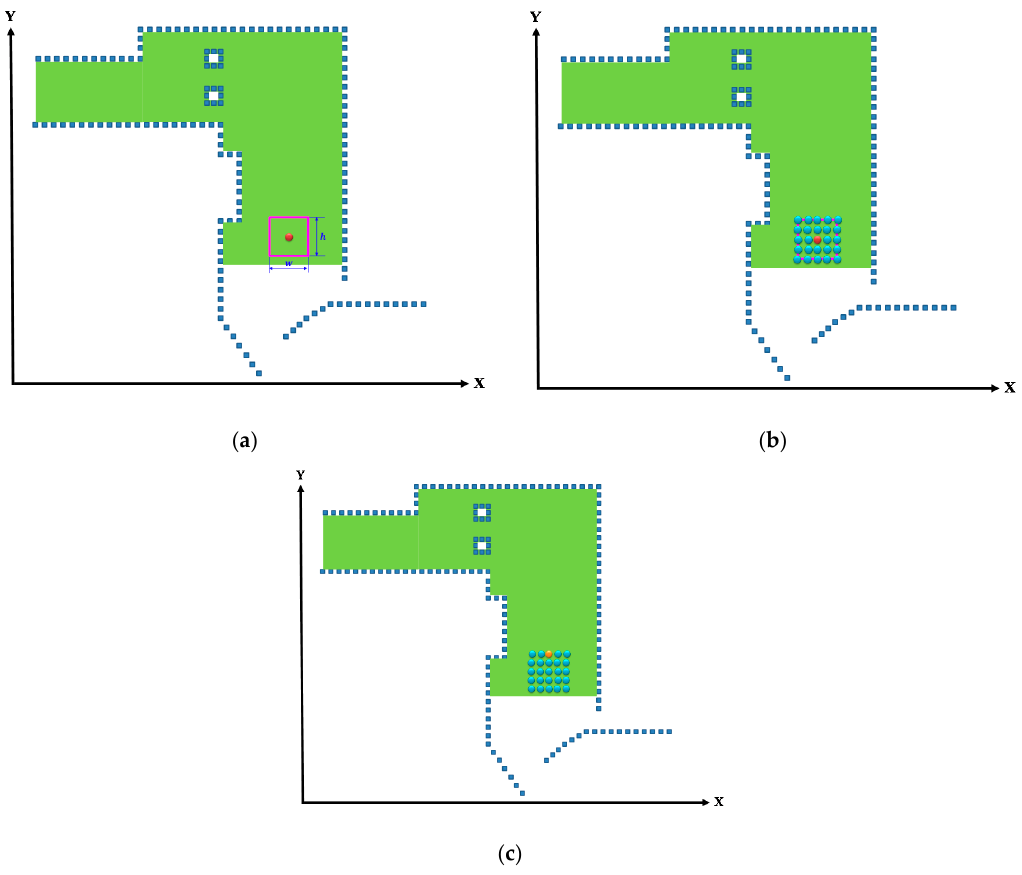
Figure 8. Locating the vehicle through window-based localization. ( a ) Window search area. ( b ) Current possible locations of the vehicle. ( c ) Final estimated location.